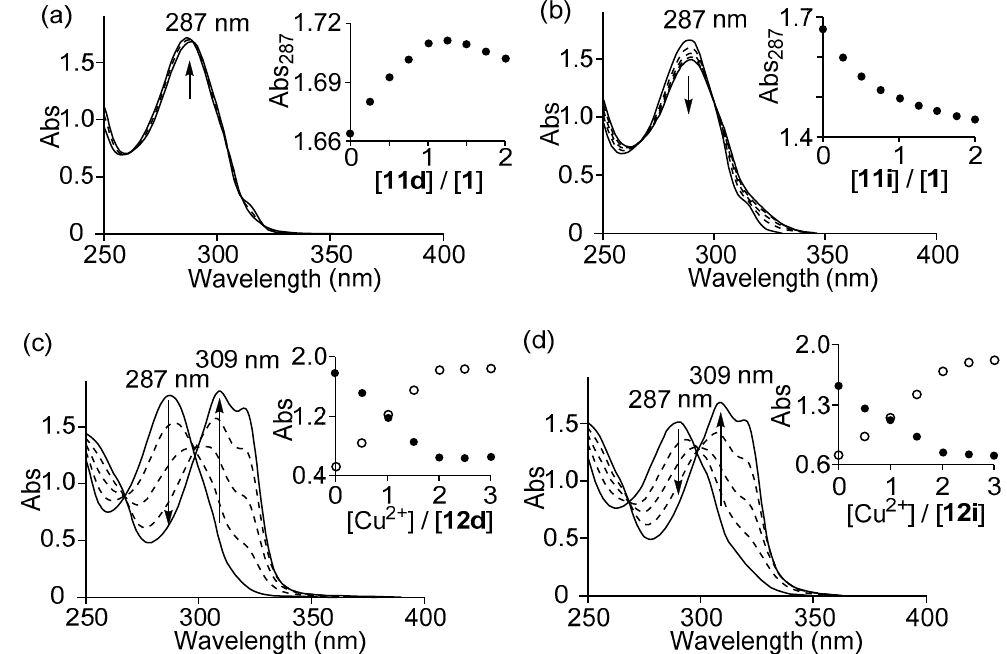
Figure 1. ( a ) UV/Vis titration of 1 (80 μ M) upon the addition of 11d in 10 mM HEPES buffer (pH 7.4 with I = 0.1 (NaNO 3 )) at 25 °C; ( b ) UV/Vis titration of 1 (80 μ M) upon the addition of 11i in 10 mM HEPES buffer (pH 7.4 with I = 0.1 (NaNO 3 )) at 25 °C; ( c ) UV/Vis titration of 12d (40 μ M) upon the addition of Cu 2+ in 10 mM HEPES buffer (pH 7.4 with I = 0.1 (NaNO 3 )) at 25 °C; ( d ) UV/Vis titration of 12i (40 μ M) upon the addition of Cu 2+ in 10 mM HEPES buffer (pH 7.4 with I = 0.1 (NaNO 3 )) at 25 °C. The insets in Figure 1( a ) and ( b ) show the change in the absorbance at 287 nm, and the insets in Figure 1( c ) and ( d ) show the decrease in absorbance at 287 nm (closed circles) and the increase in absorbance at 309 nm (open circles).